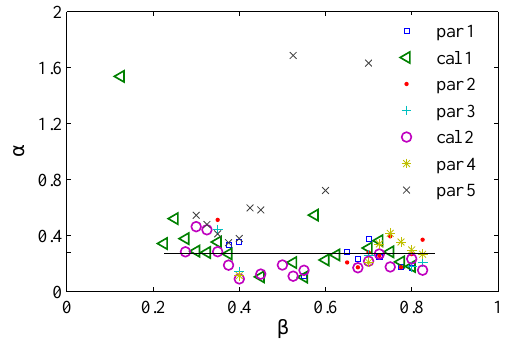
Fig. 6. Profiles of α across the river section for boat-mounted ADCP parameter and calibration surveys. In the conversion model α = 0 . 28 is taken for β > 0 .